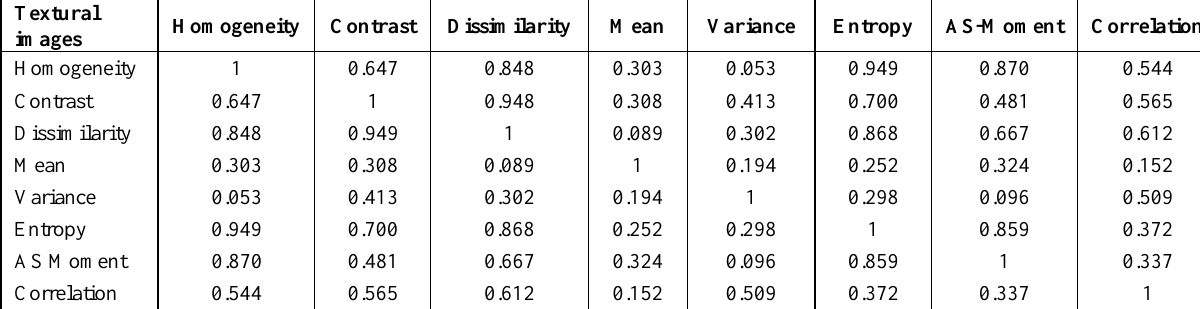
Table 2. Correlation matrix of SAR textural images generated using Grey Level Co- occurrence Matrix. Three least correlated (independent) textural images: mean, variance, and homogeneity, were retained as inputs to the